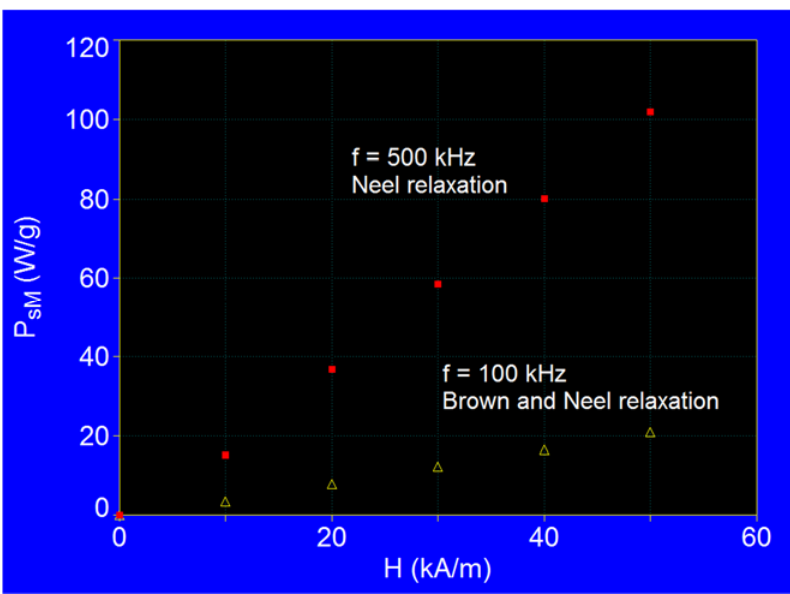
Figure 8. The maximum specific loss power in dispersed Fe 3 O 4 – γ -CDs bionanoparticles as a function of the amplitude of magnetic field.